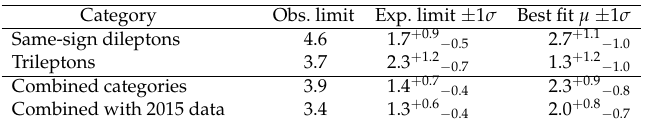
Figure 12. Best fit signal strength for the 2016 analysis alone (left) and the combined 2015 and 2016 analysis (middle), in the dilepton and trilepton channels. Negative log-likelihood as a function of the signal strength for the combined 2015 and 2016 result, as observed in the data and expected from simulation (right) [8]. Table 3. Observed and expected asymptotic 95% C.L. upper limits on and best fit value of the signal strength parameter ( µ )